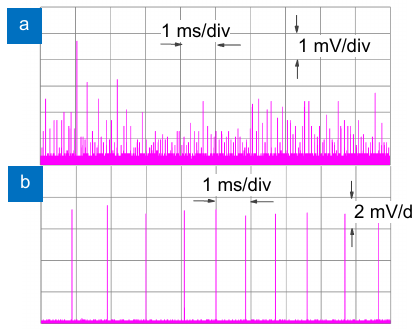
Fig. 4 | Comparison in pulse trains from the hybrid cavit y before (a) and after (b) using the Cr 2+ :ZnSe.